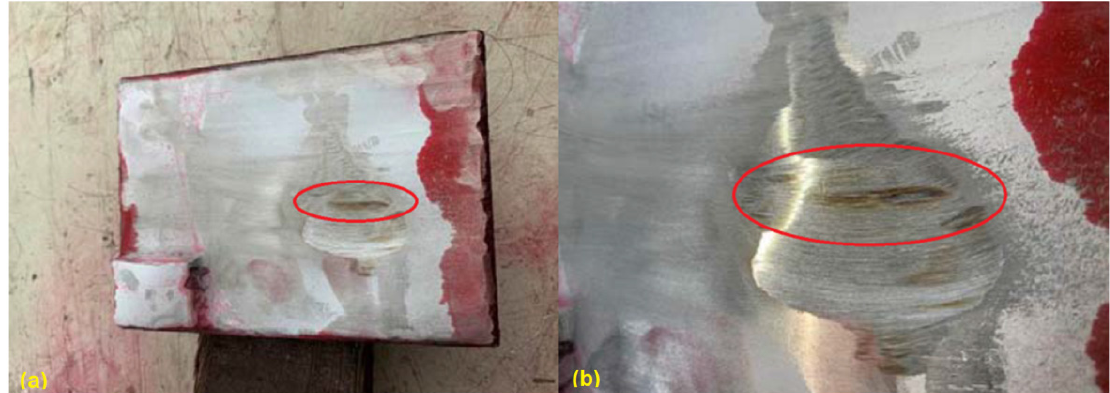
Figure 3. Appearance of the welded plate after liquid penetrate test ( a ) and cracks ( b ).